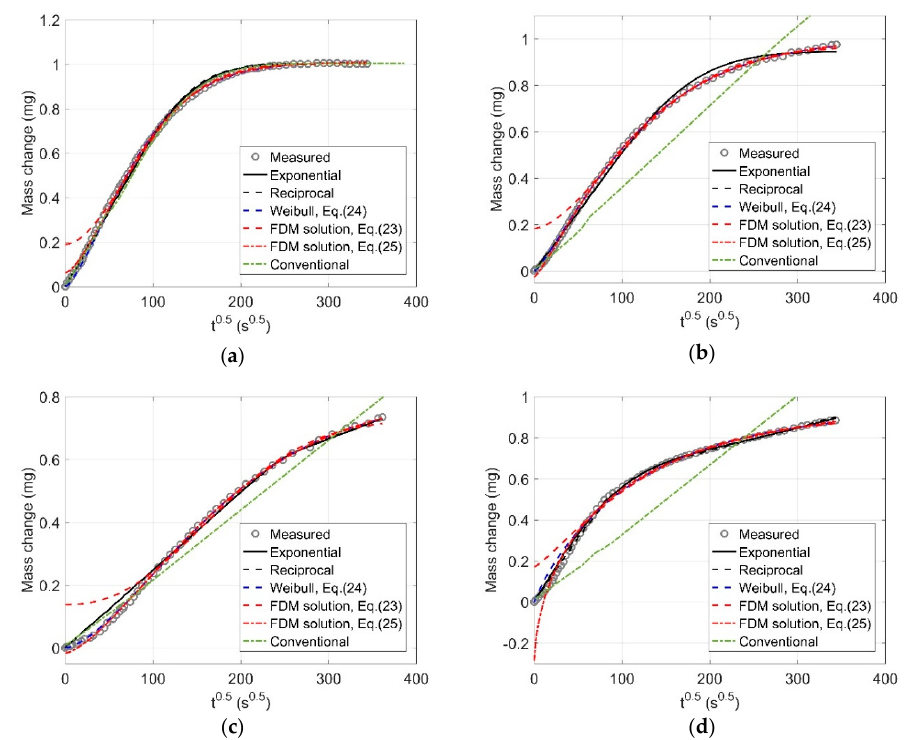
Figure 2. Measured and fitted anomalous moisture mass change curves for different drying or wetting conditions: ( a ) wetting at 50% RH from initial 60% RH; ( b ) wetting at 60% RH from initial 70% RH; ( c ) drying at 80% RH from initial 70% RH, and ( d ) drying at 80% RH from initial 90% RH.